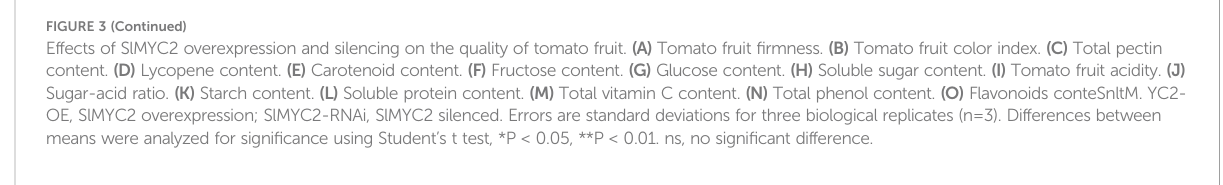
( Figure 5D ) and the transpiration rate (Ts) ( Figure 5E ) of leaves were signi fi cantly reduced, while the changes in chlorophyll b ( Figure 5B ) and stomatal conductance (Gs) ( Figure 5F ) were not signi fi cant;however,theintercellularcarbondioxideconcentration (Ci) was prominently increased ( Figure 5G ) . The results suggested that the photosynthesis of tomato seedlings was inhibited after that RAP inhibited the TOR signaling pathway, but this change was caused by non-stomatal factors.